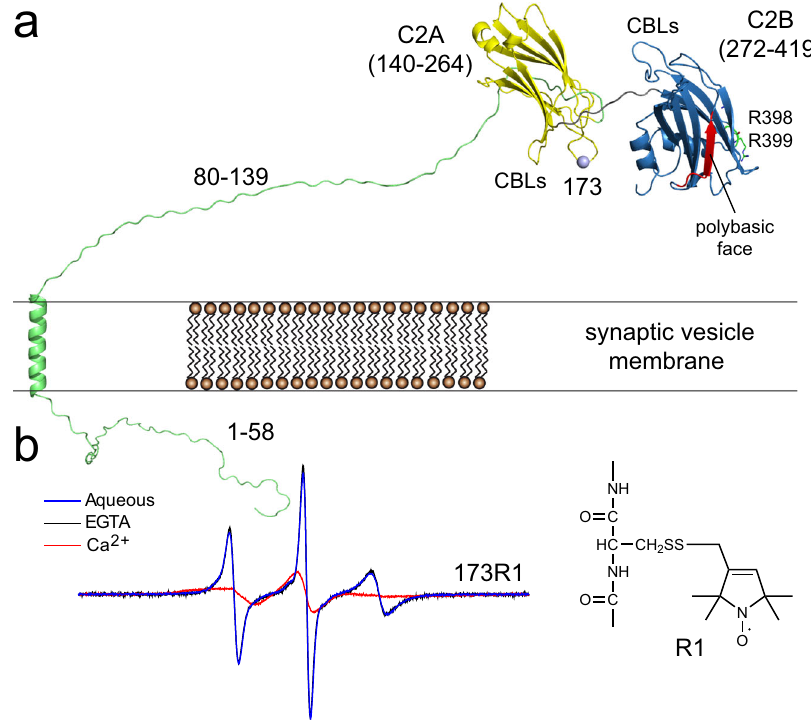
Fig. 1 EPR spectroscopy is sensitive to membrane proximity and insertion of labeled Syt1. a Model for Syt1 on the vesicle membrane surface showing position 173 in the 1st Ca 2 + -binding loop (CBL) of the C2A domain (yellow). The position of the polybasic face (red) and R398, 399 side chains are shown for C2B (blue). b EPR spectra from an R1 label attached to site 173. In the presence of Ca 2 + , the domain inserts into the bilayer, which alters the sampling of rotamers by the R1 side chain and broadens the EPR